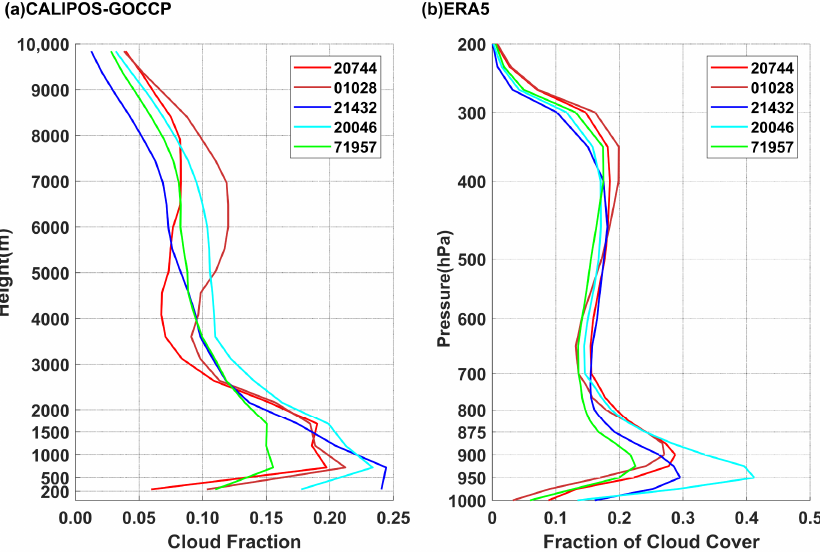
Figure 6. Vertical climatology pro fi les of seasonal mean cloud fractions averaging from the four grid points nearest to each of the fi ve sounding stations, based on ( a ) 2006–2017 GOCCP data and ( b ) 2001–2017 ERA5 data.